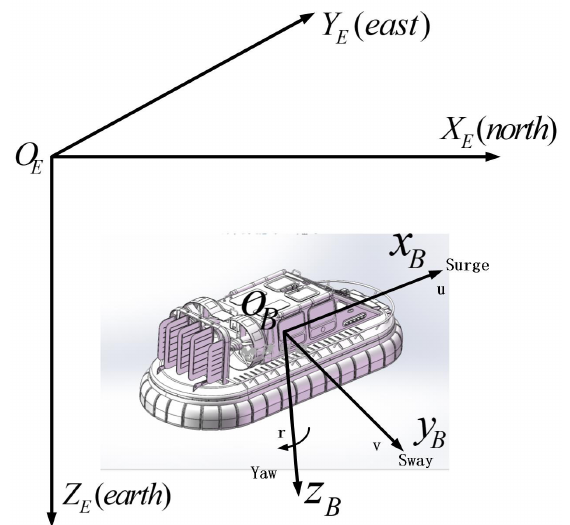
Figure 1. Scheme diagram of the trajectory tracking system of Air Cushion Vehicle